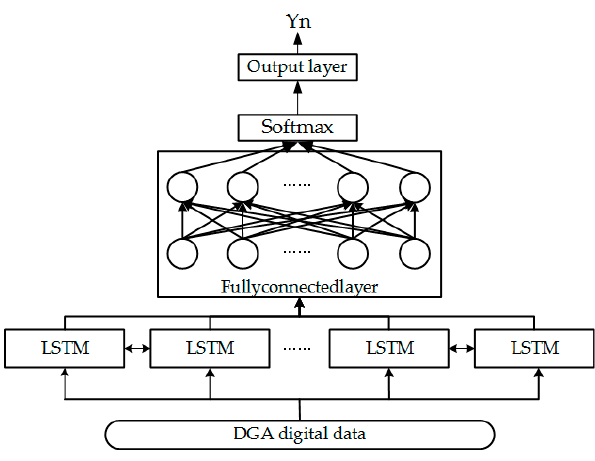
Figure 4. The structure of the long short-term memory (LSTM)-based diagnostic network.